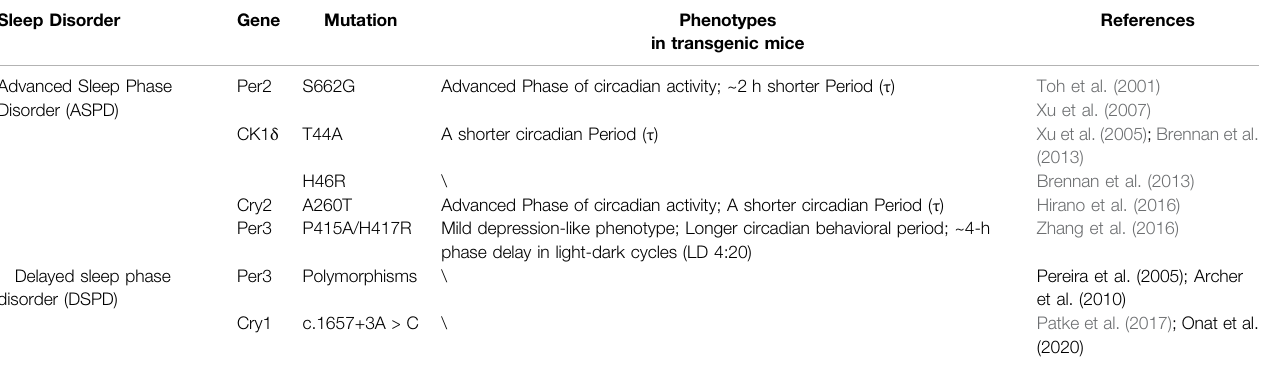
TABLE 1 | Genes implicated in human circadian rhythm sleep